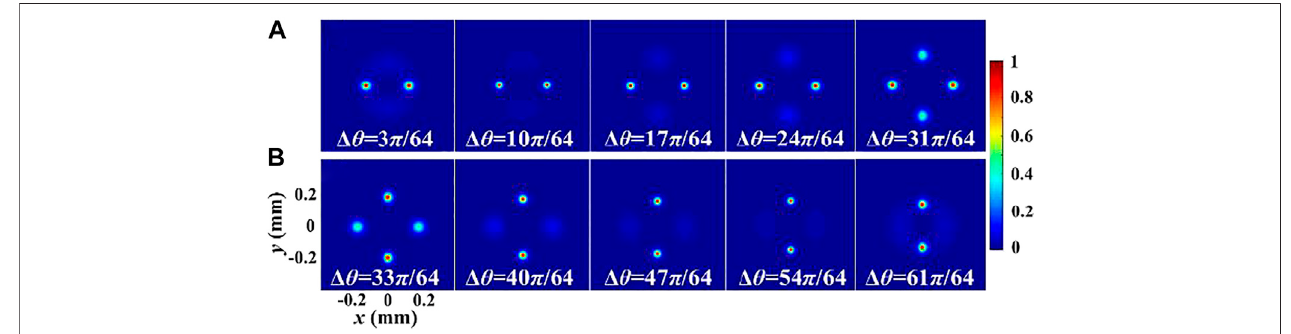
FIGURE 3 | Intensity distribution of self-focusing spots with various phase differences: (A) Δθ ∈ ( 0 , π / 2 ) and (B) Δθ ∈ ( π / 2 , π ) ,